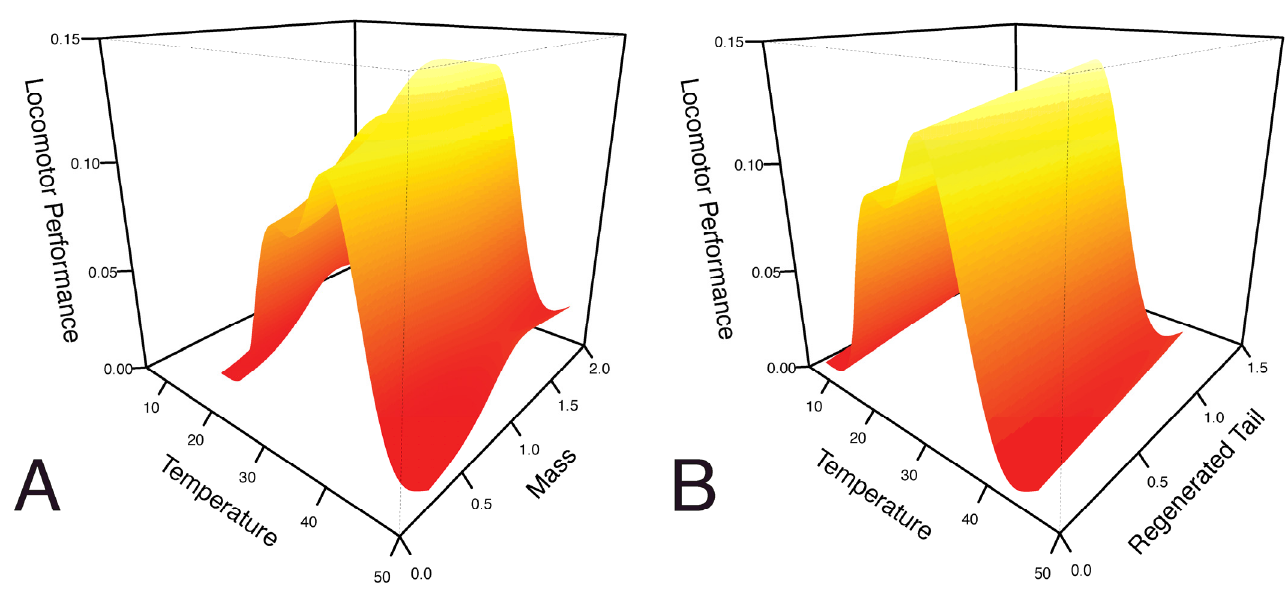
Figure 2. Locomotor performance (sprint speed) of the lizard Micrablepharus atticolus as a function of ( A ) body temperature and body mass, and ( B ) body temperature and length of the regenerated portion of the tail. The surface represents the predictions of a generalized additive mixed model (GAMM).